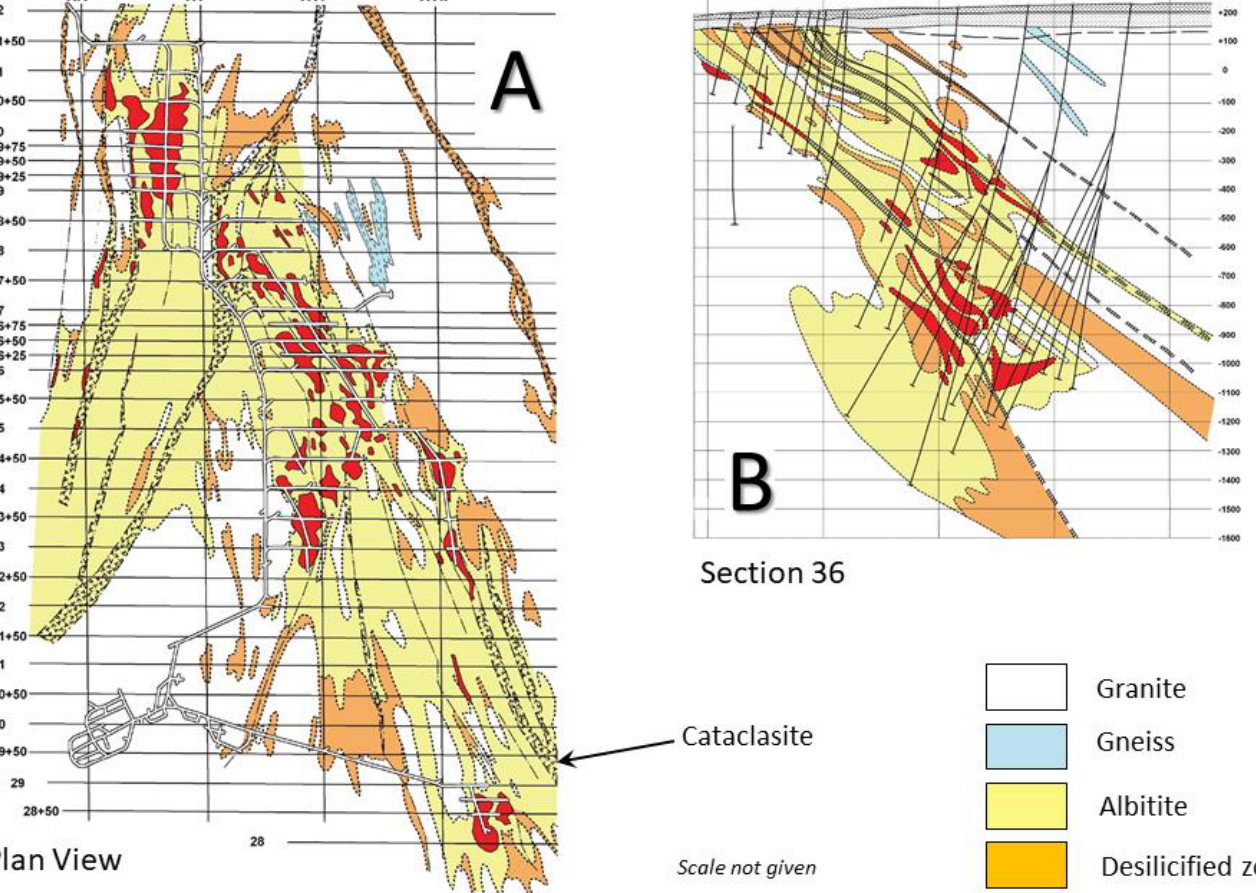
Figure 4. A —plan view of the Novokostantynivka deposit, Kropyvnytskyi district. B —section of the Novokostantynivka deposit, Kropyvnytskyi district. Source: Bararzhiyev. Cuney & Emetz pers.